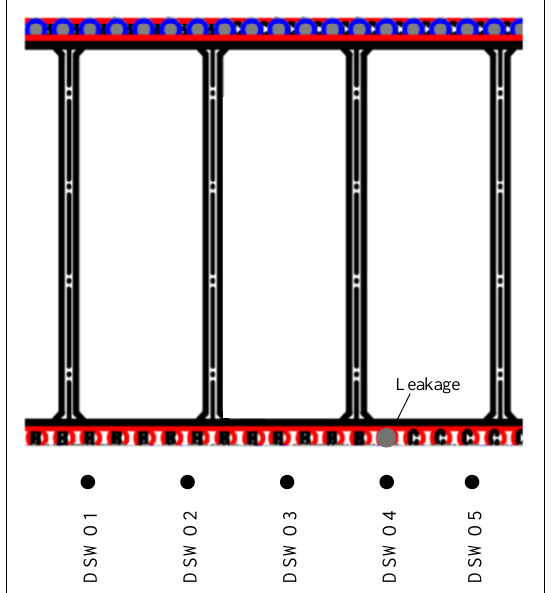
Figure 5. Water level monitoring layout diagram.